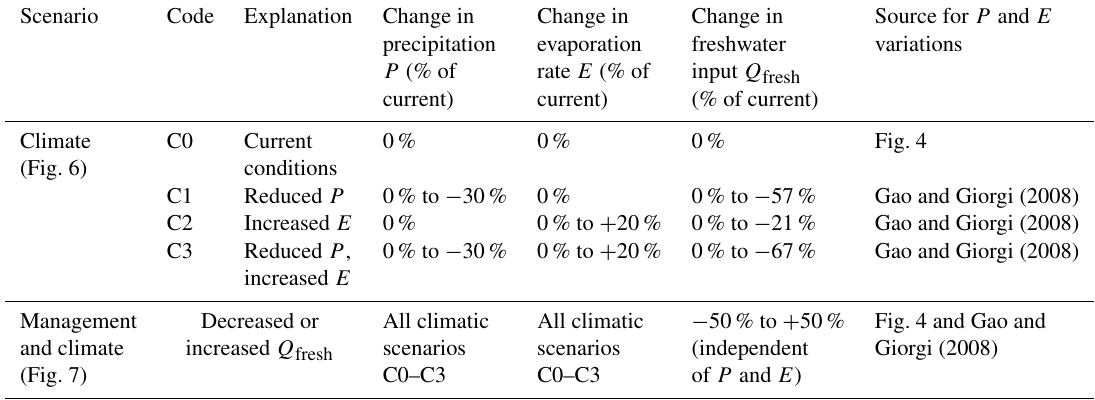
Table 2. Climatic and management scenarios. Variations are indicated as percentage change compared to current conditions. In scenar- ios C1–C3, freshwater inputs are either kept as under current conditions or decreased as a consequence of a higher potential evapotranspira- tion / precipitation ratio (black and red curves in Figs. 6a and 7a,